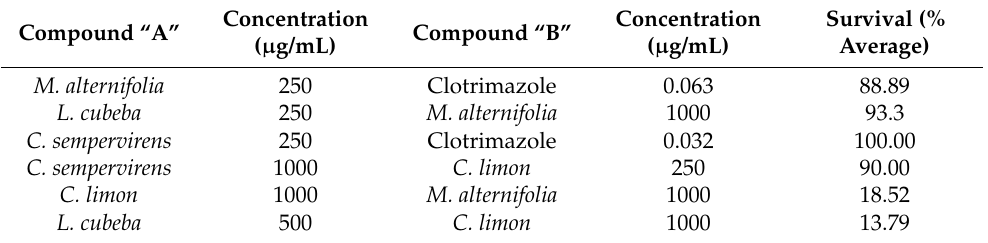
Table 6. Survival rate (%) of C. elegans subjected to combinations of essential oil and clotrimazole after 24 h of